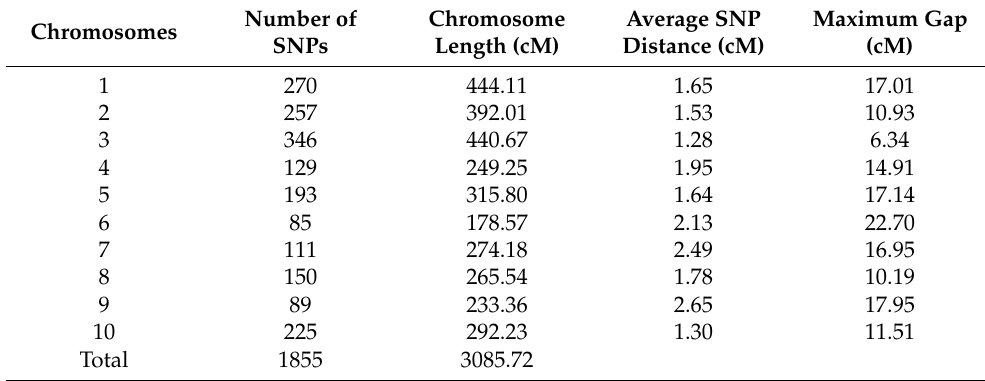
Table 3. Basic information of genetic linkage map for the F 2 population.